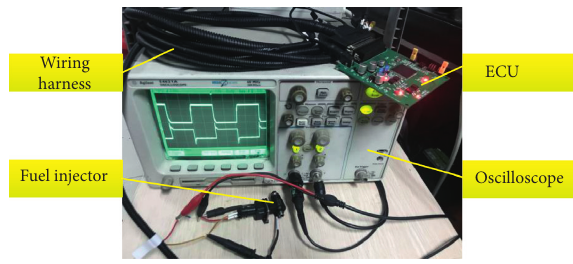
Figure 10: Injector test picture.